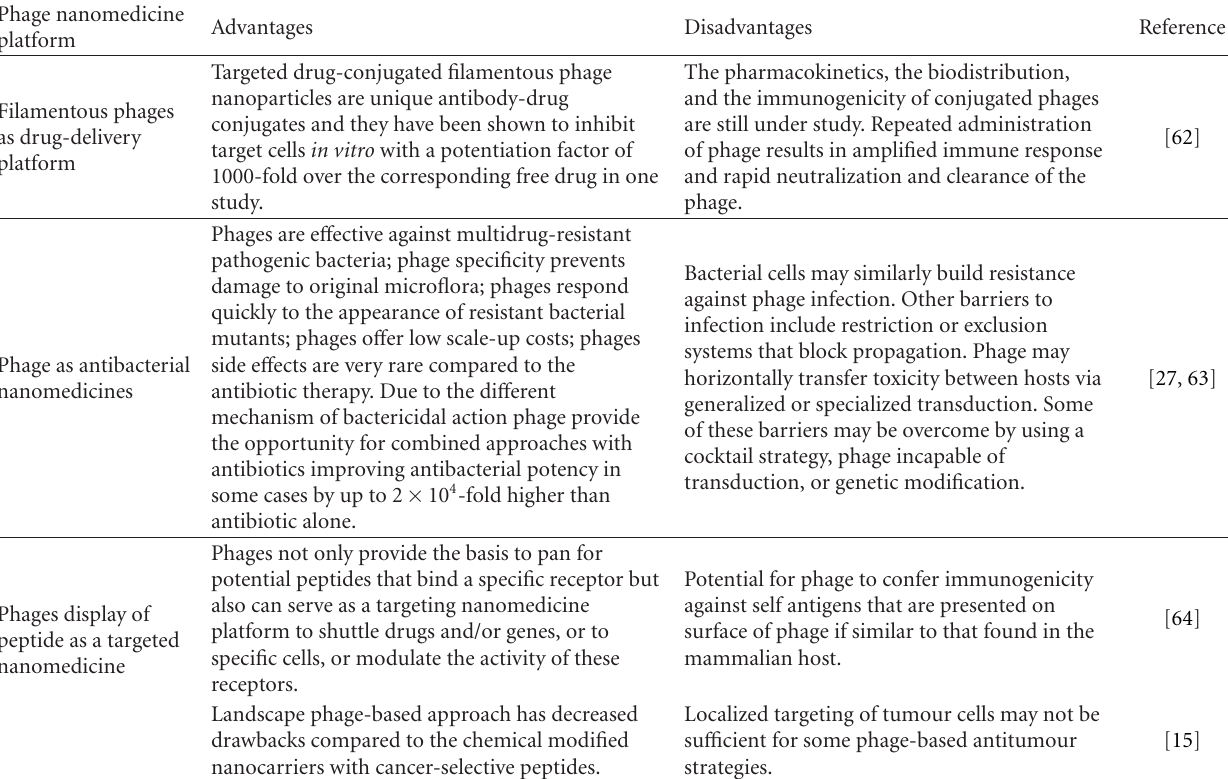
Table 2: Advantages and disadvantages of phages as